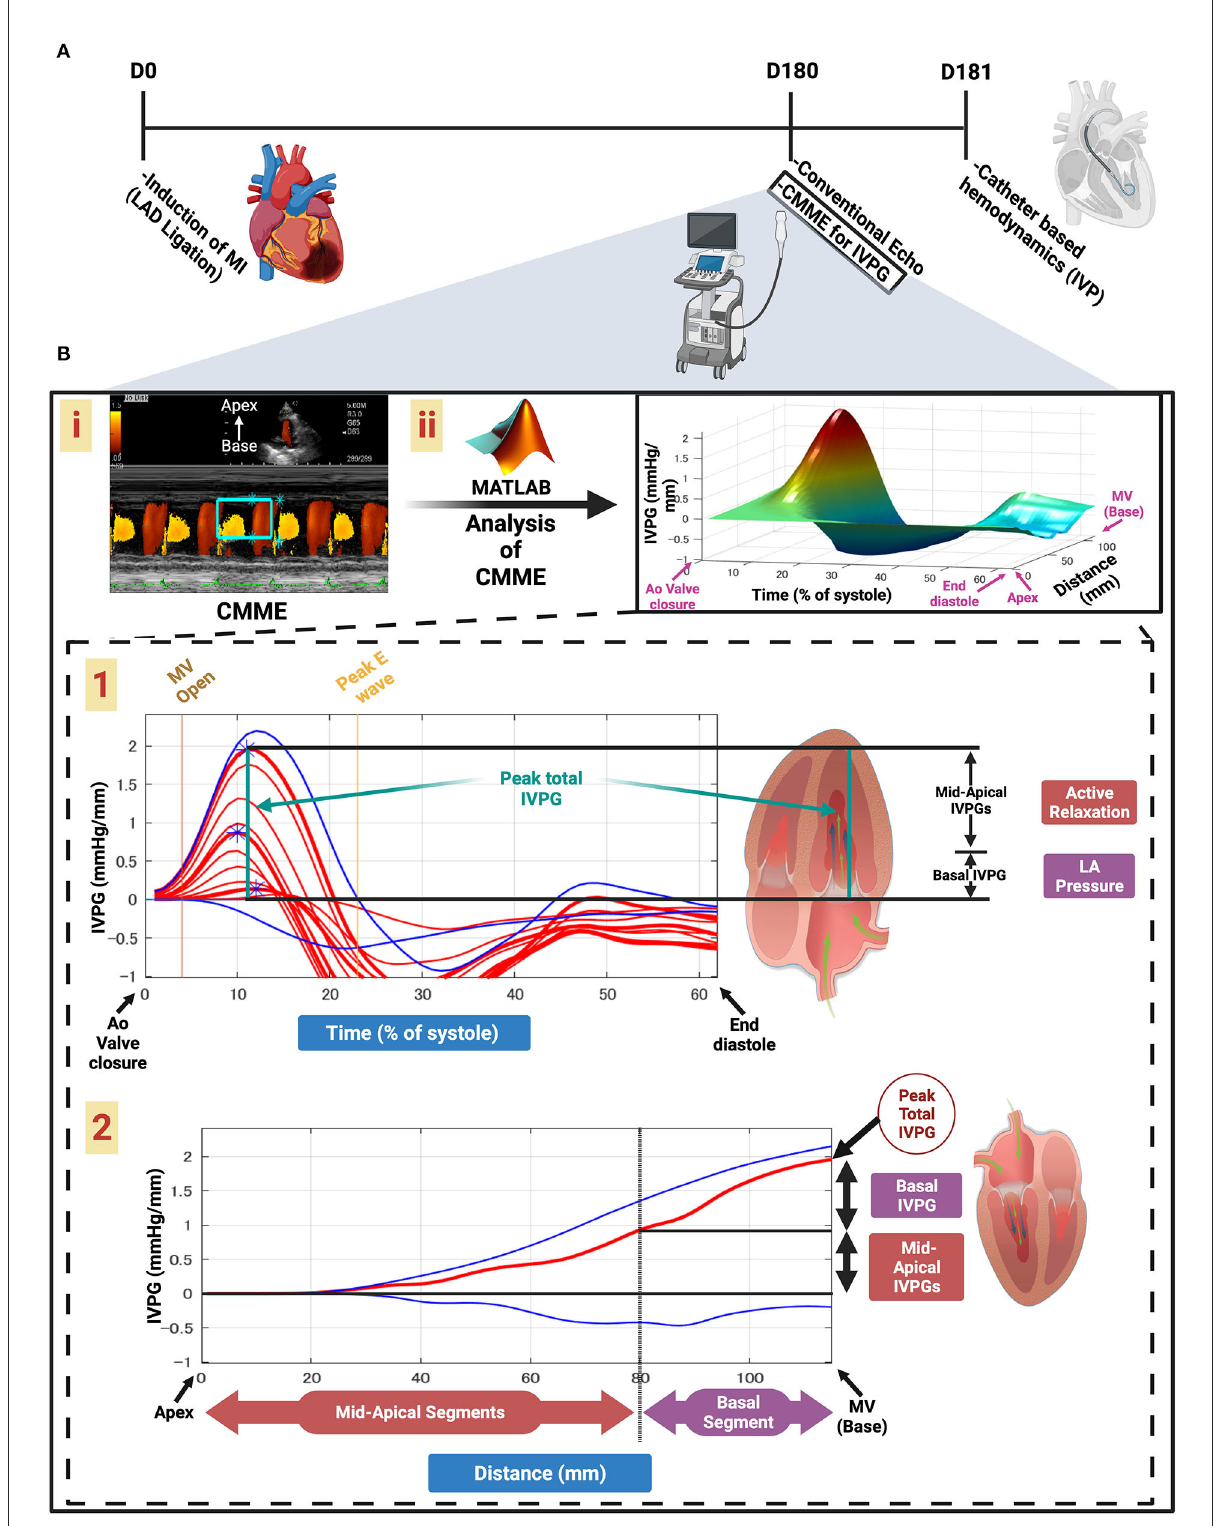
FIGURE1 Schematic illustration of this study design and calculation of IVPG. Timeline of the study (A) . Color M-mode echocardiography (CMME) for intraventricular pressure gradient (IVPG) (B) . Apical four-chamber view CMME to trace the inflow tract from the left atrium (LA) to the apex of